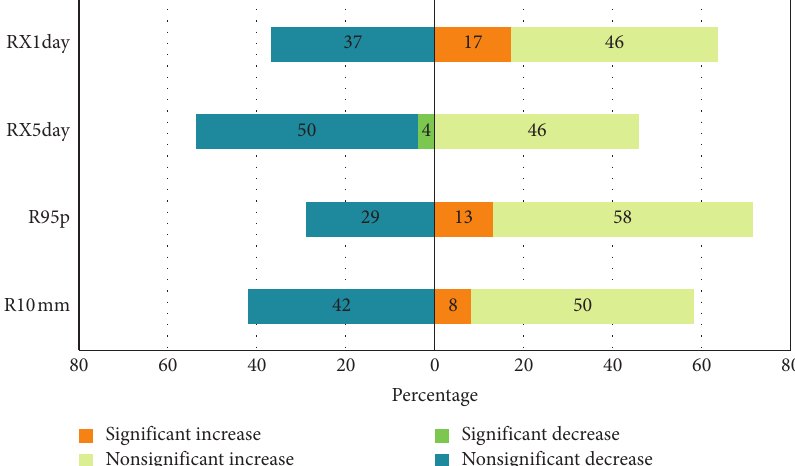
Figure 3: Percentages of stations for each extreme precipitation index that showed increasing and decreasing